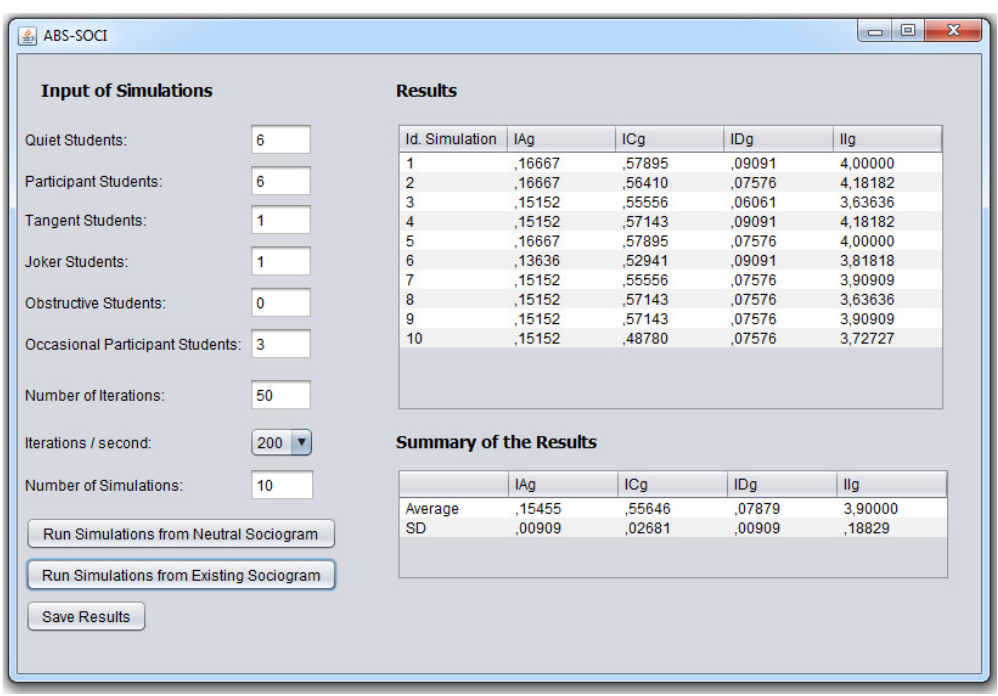
Figure 1. Frame for showing the graphical evolution of sociograms.